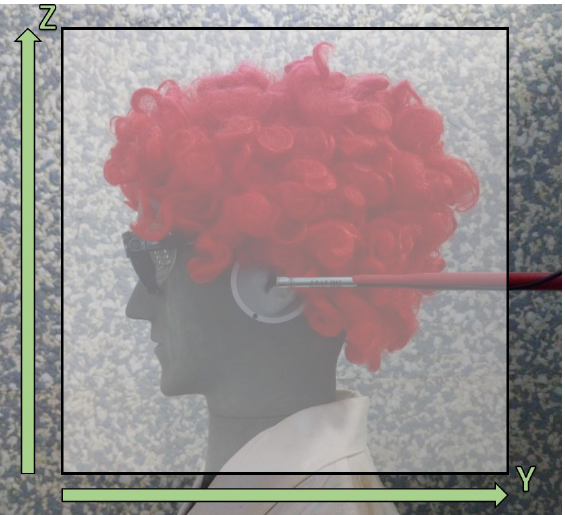
Figure 10. A view from the left side of the artificial head with the scanning area marked by the black frame. Scanning axes together with the USPM microphone at the origin of the scans are also